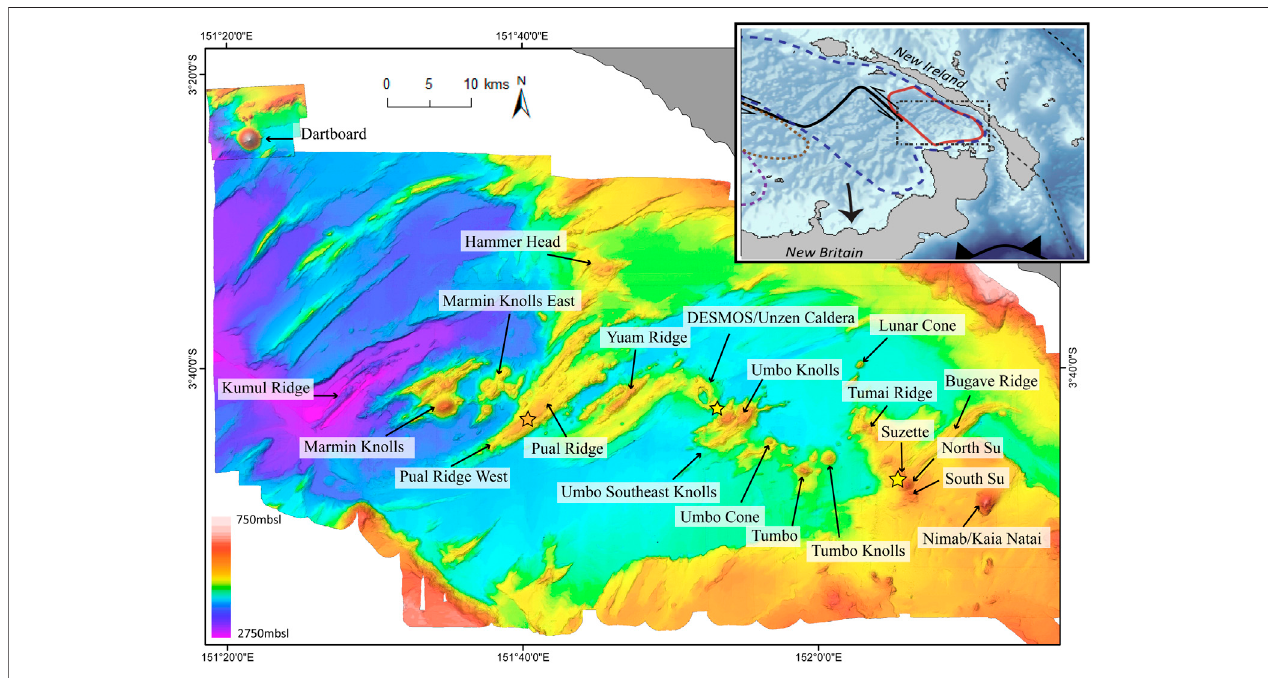
FIGURE 2 | Digital elevation model using combined bathymetric data across the EMB. RV Sonne 2011 and MV 2012 cruises are the primary bathymetric data sources. The known volcanic features are shown. Stars represent SMS systems: orange star, major mineralized hydrothermal system (e.g., PACMANUS); yellow star, Cu-Au SMS ore deposits (e.g., Solwara 1 and Solwara 12). Inset is a portion of Figure 1 that highlights location of the